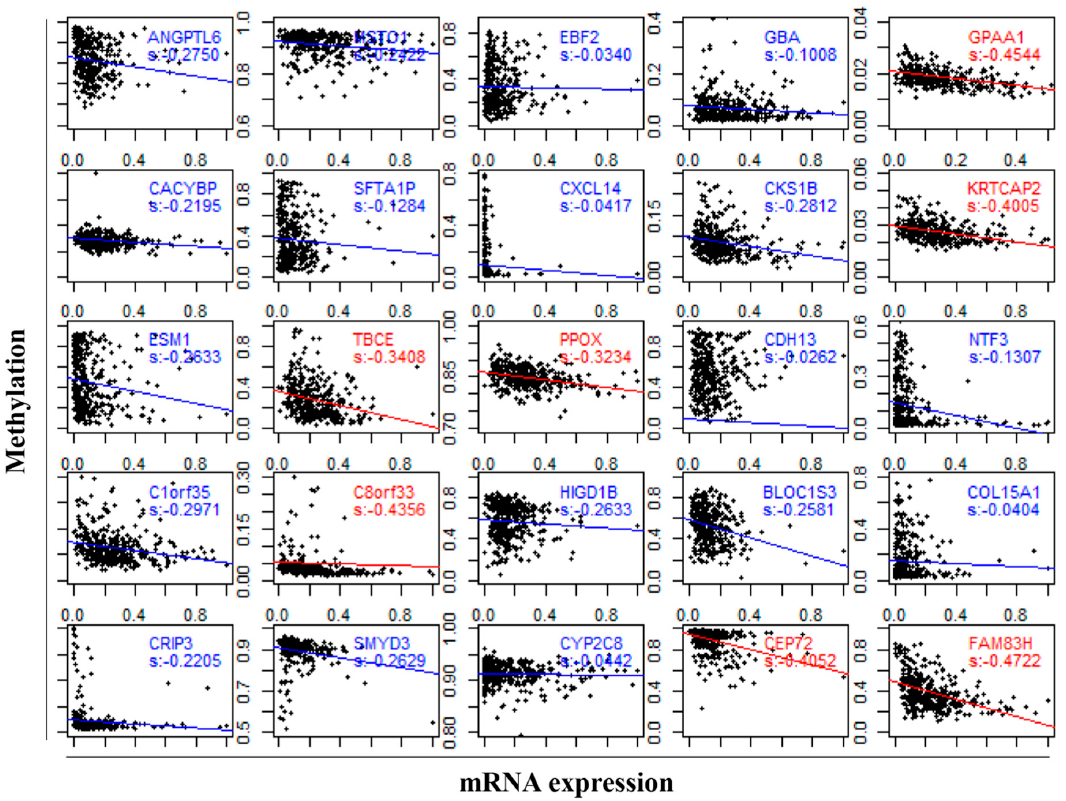
Figure 5. The association between the gene expression and DNA methylation of biomarkers in LIHC. The red label indicates a significant negative correlation by the Spearman test (s < − 0.3), and the red line and blue line represent the regression line.